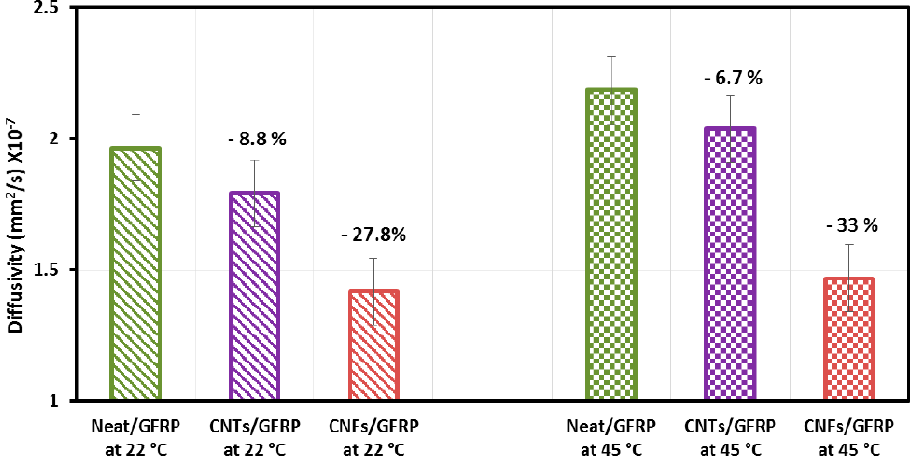
Figure 8. Diffusivity of Neat/GFRP, MWCNTs/GFRP and CNFs/GFRP composites at temperatures of 22 and 45 °C.